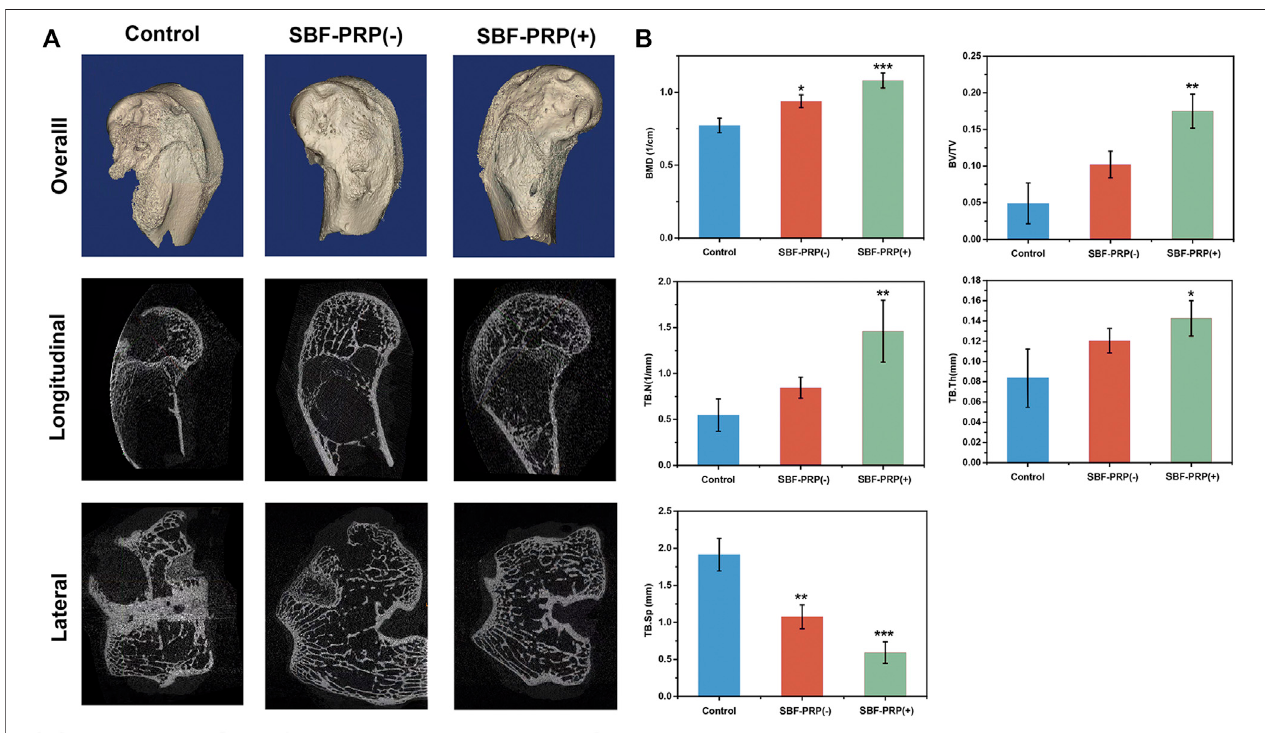
FIGURE 8 | In Vivo osteogenic assessment of IPN M-ALG/PEG hydrogels. (A) Reconstructed 3D micro-CT and sectional images of femoral condyle at 8 weeks after treated with IPN M-ALG/PEG hydrogels. (B) Quantitatively evaluation of regenerated area by the analyzing parameter of micro-CT: BMD, BV/TV, TB.N, TB.Sp and